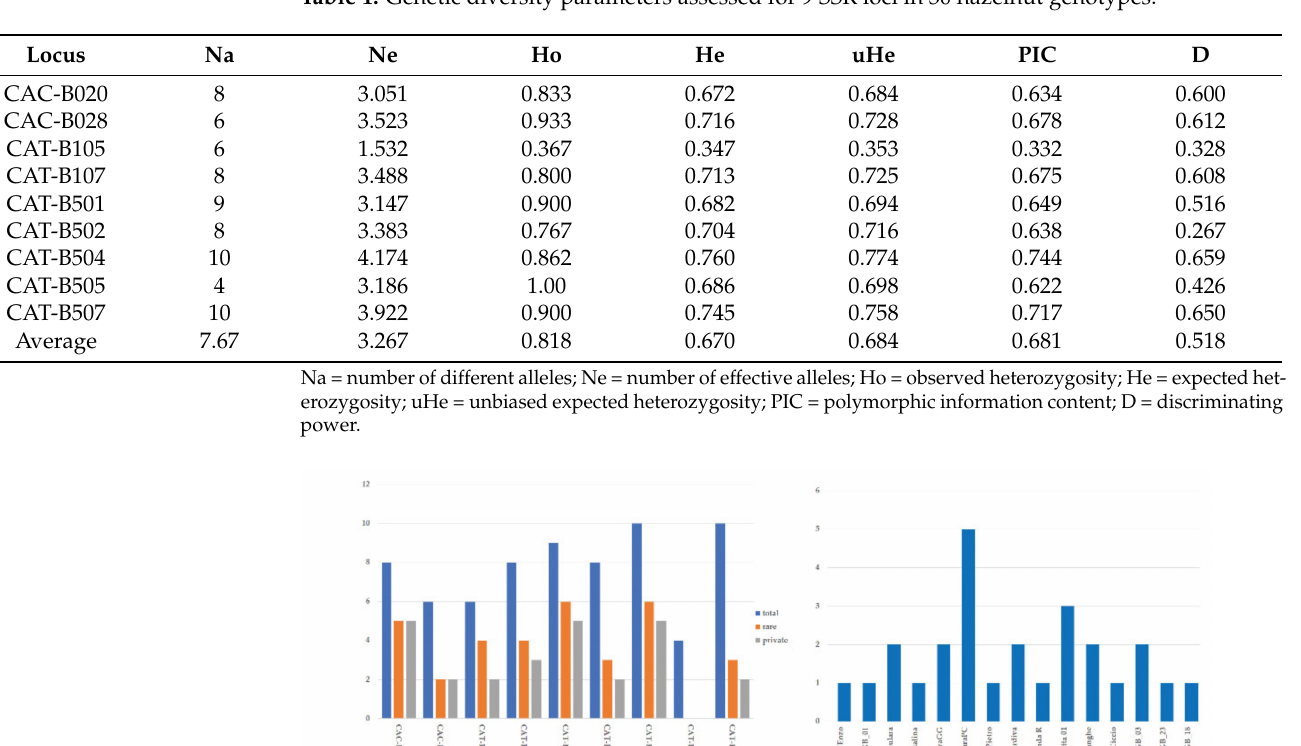
Table 1. Genetic diversity parameters assessed for 9 SSR loci in 30 hazelnut genotypes.